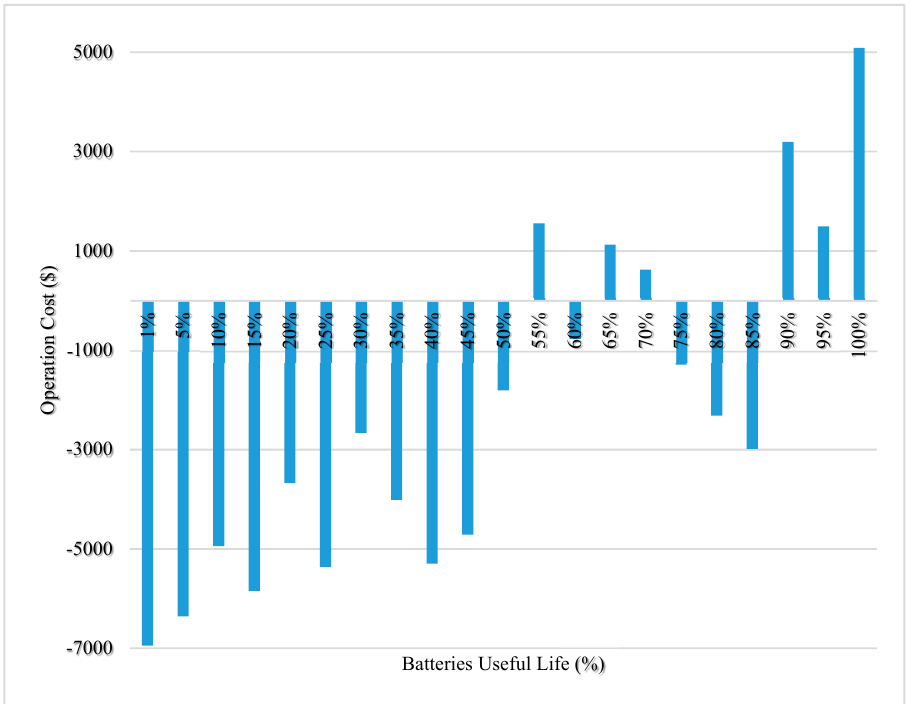
Figure 17. Total optimal operation cost vs. batteries useful life.